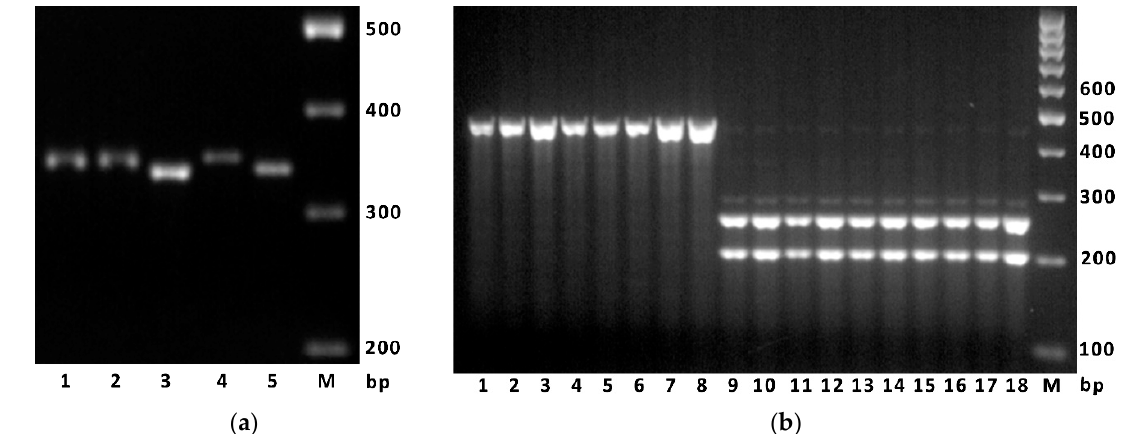
Figure 4. ( a ) An example of electrophoresis of the PCR marker designed for detecting the c.126_134del polymorphism. The PCR products were obtained using the primers GRF3A-Q42-F/R and DNA of the following wheat accessions: lane 1—Vid, 2—Stan, 4—Altigo, 3 and 5—Novosibirskaya 67, M—size standard M-100 (Syntol LLC, Moscow). ( b ) An example of electrophoresis of the marker detecting the c.495G>T polymorphism in GRF3-2A . The PCR products obtained using pri- mers GRF3A-Q165-F/R and digested using Sfa N I endonuclease. Lanes 1–8—accessions having the GRF3-2Aa allele (nu- cleotide G), two lanes each: Grom, Altigo, Velena, Sila; lanes 9–18—accessions having the GRF3-2Ab allele (nucleotide T),